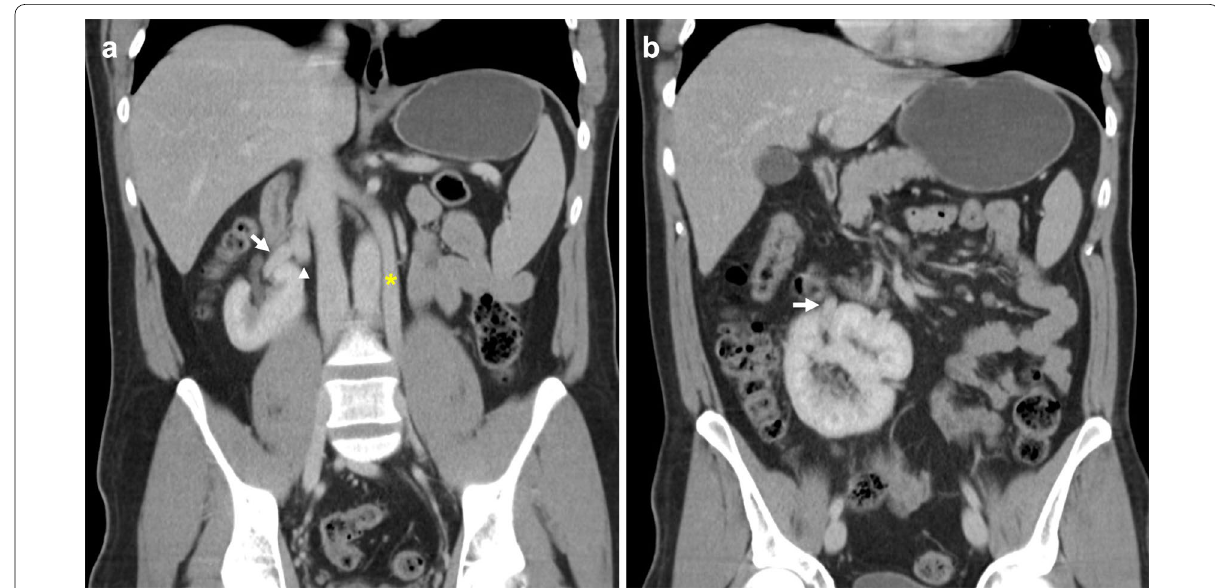
Fig. 5 Duplicated IVC with right-sided crossed fused renal ectopia. a Coronal CT image shows a duplicated IVC (asterisk) crossing the midline to drain into the right-sided suprarenal IVC. The right renal vein (arrow) and vein of the left ectopic kidney (arrowhead) join before draining into the orthotopic IVC. b Coronal CT demonstrates the right-sided crossed fused renal ectopia and its renal vein (arrow)